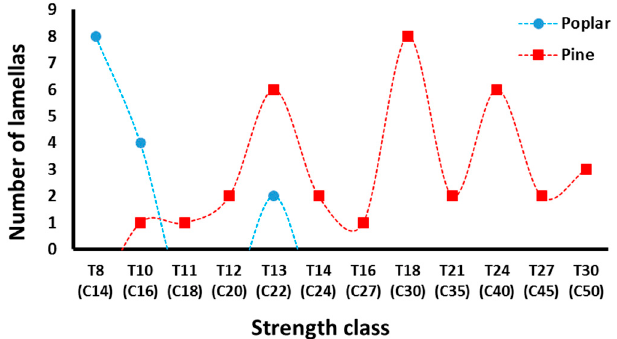
Figure 4. Distribution of planks according with the T and C strength class.